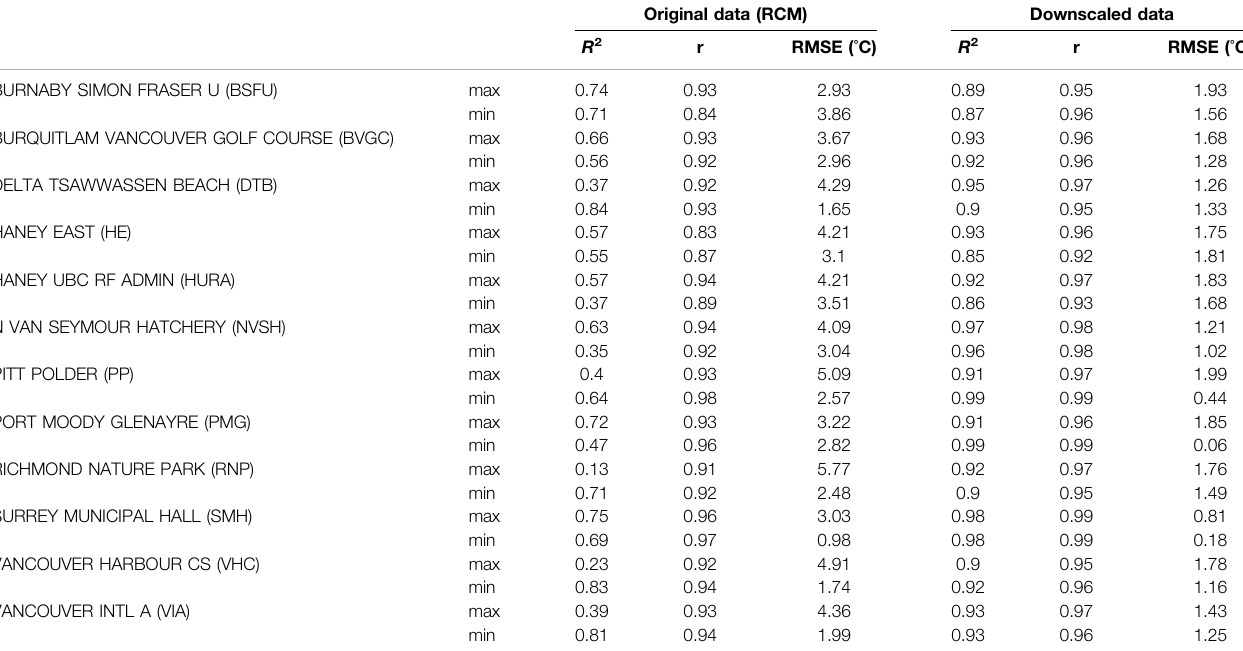
TABLE 1 | Original performance of RCM outputs and validation results (all monthly data between 1996 and 2005) of the developed downscaling